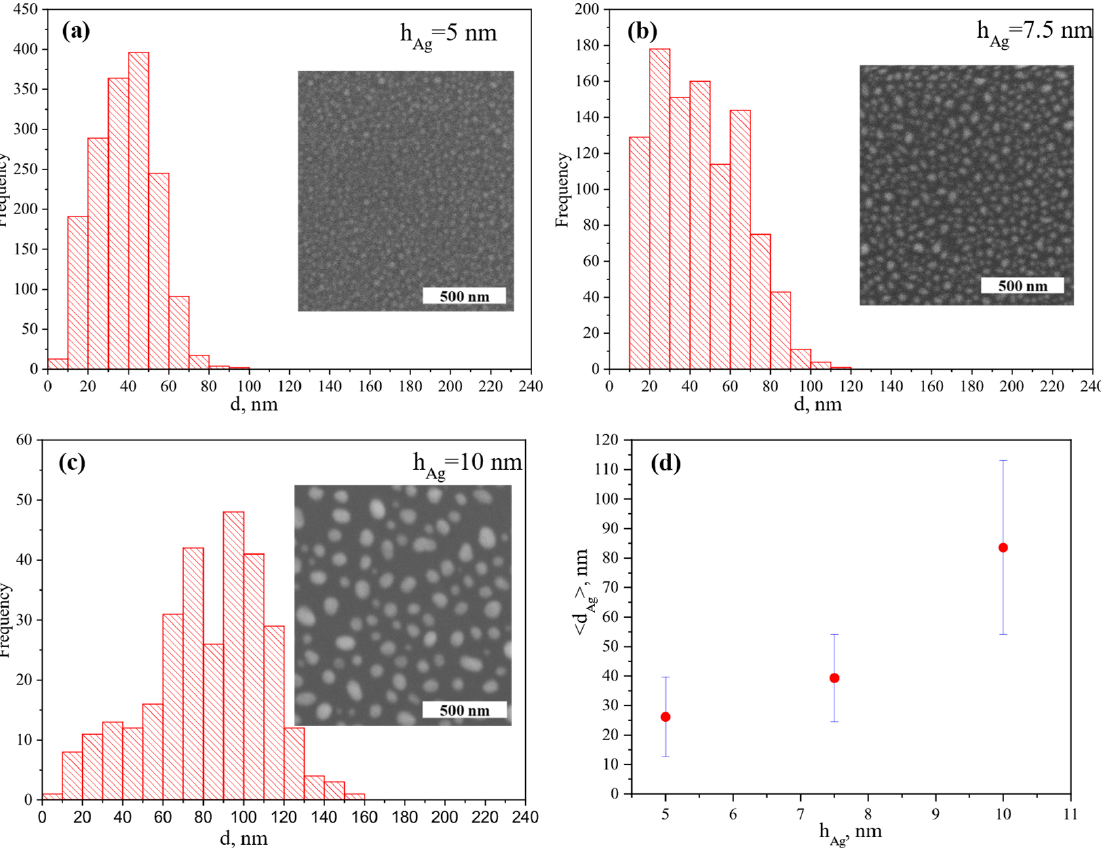
Figure 3. The diameter ( d ) distribution of AgNPs and SEM of AgNP/TiO 2 structures obtained by SSD process ( T a = 400 ◦ C, t a = 60 min) using different h Ag : ( a ) 5 nm; ( b ) 7.5 nm; ( c ) 10 nm, and ( d ) the average NP diameter ( d ) dependence on h Ag